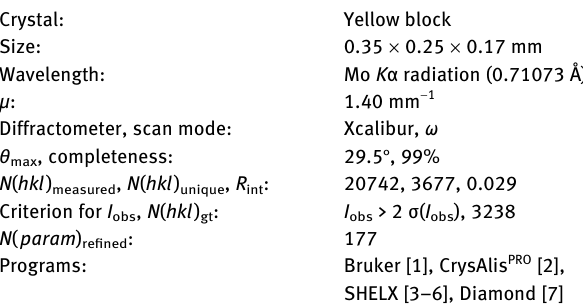
Table 1 contains crystallographic data and Table 2 contains the list of the atoms including atomic coordinates and displacement parameters.